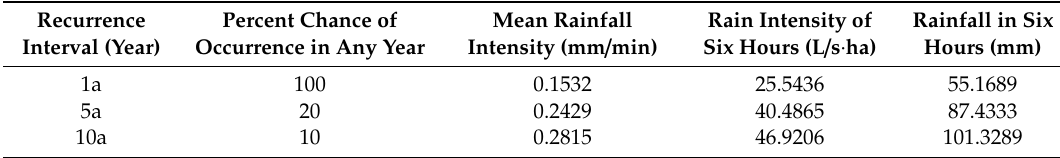
Table 3. Six-hour rainfall in di ff erent return